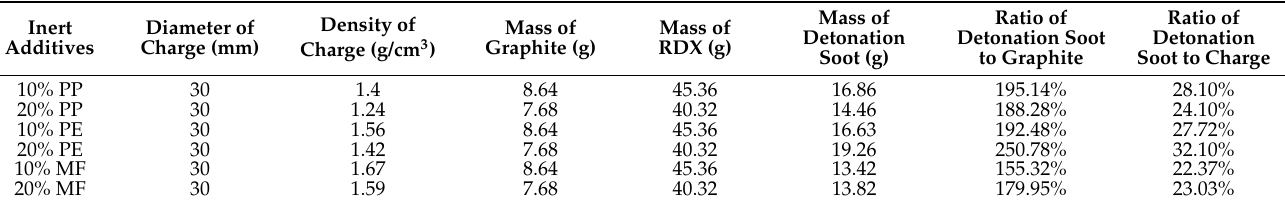
Table 2. Experimental verification scheme and results.